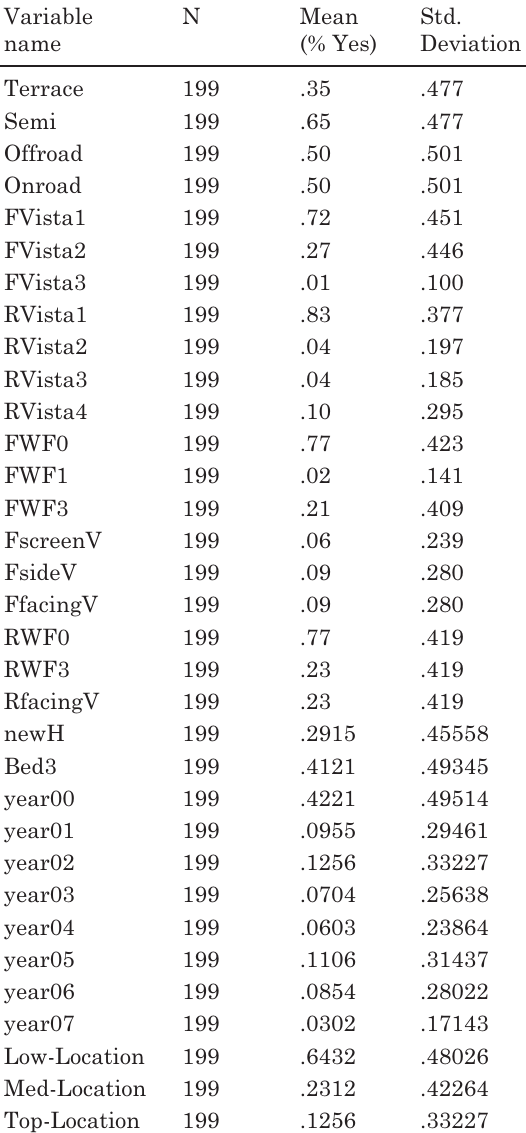
Table 2. Descriptive statistics for dummy